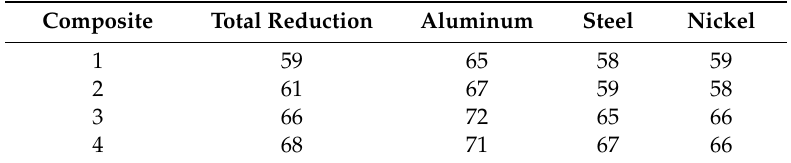
Table 1. The achieved total thickness reduction and the thickness reduction achieved in the individual metal layers for some selected composites. For the steel and the nickel layers in the composites, the average thickness reduction obtained in one layer is given. All thickness reductions are given in [%].